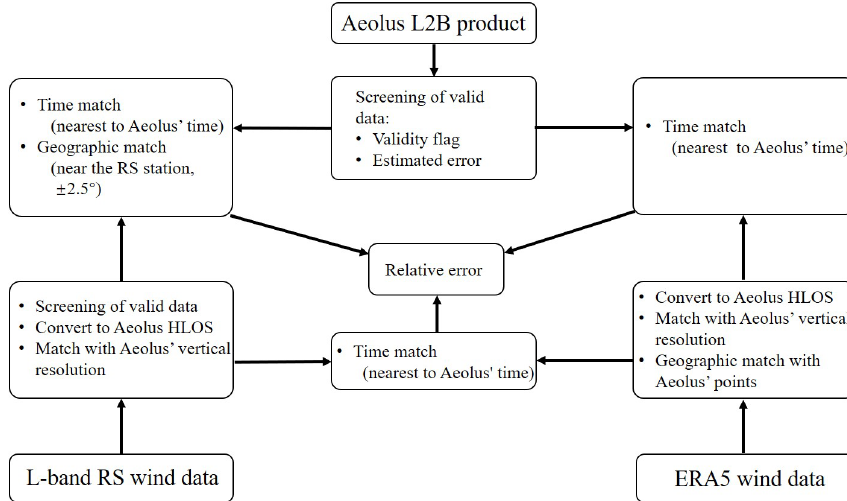
Figure 3. Main processing procedures of Aeolus, L-band RS, and ERA5 wind data.